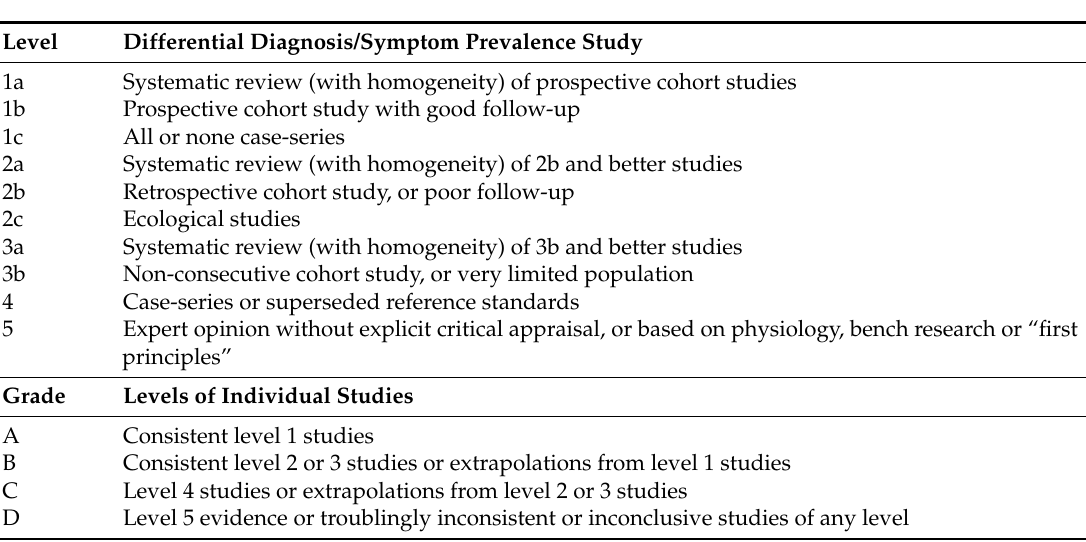
Table 2. Oxford Levels of Evidence & Grades of Recommendation.